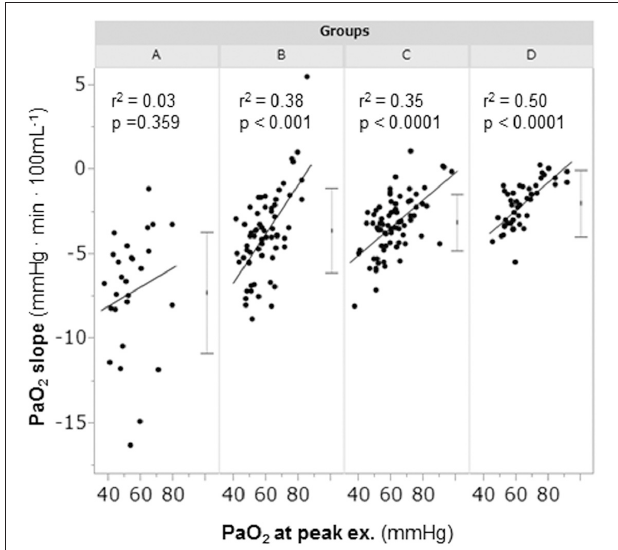
FIGURE 4 | The relationships between the PaO 2 -slope and the PaO 2 at peak exercise during cardiopulmonary exercise testing. Group A ( < 11 mL · min − 1 · kg − 1 ); group B (11 to < 15 mL · min − 1 · kg − 1 ); group C (15 to < 21 mL · min − 1 · kg − 1 ); and group D ( ≥ 21 mL · min − 1 · kg − 1 ). The horizontal lines represent the standard deviation. The dots between the horizontal lines represent the mean. PaO 2 , arterial oxygen